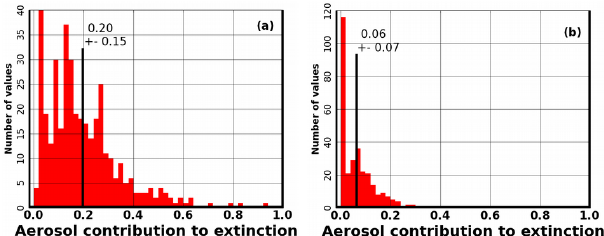
Figure 7. The contribution of hydrated aerosols to extinction of visible radiation in fogs observed during November 2011. (a) For aerosols smaller than 2.5µm in diameter ( (cid:49) ha pec M ) , (b) for aerosols larger than 2.5µm ( (cid:49) D> 2 . 5 µm pec M